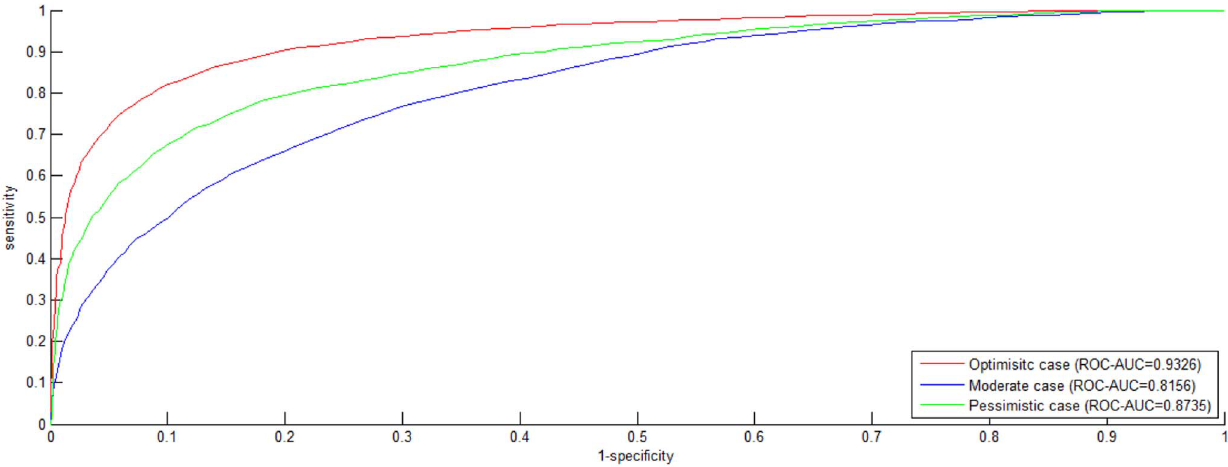
Figure 1. ROCcurve on S1 dataset. The negative data is constructed by the negative data sampling method of exclusiveness of subcellular co- localized proteins . The ROC curves in red, blue and green indicate the performance for the Optimistic case, the Moderate case and the Pessimistic case, respectively.